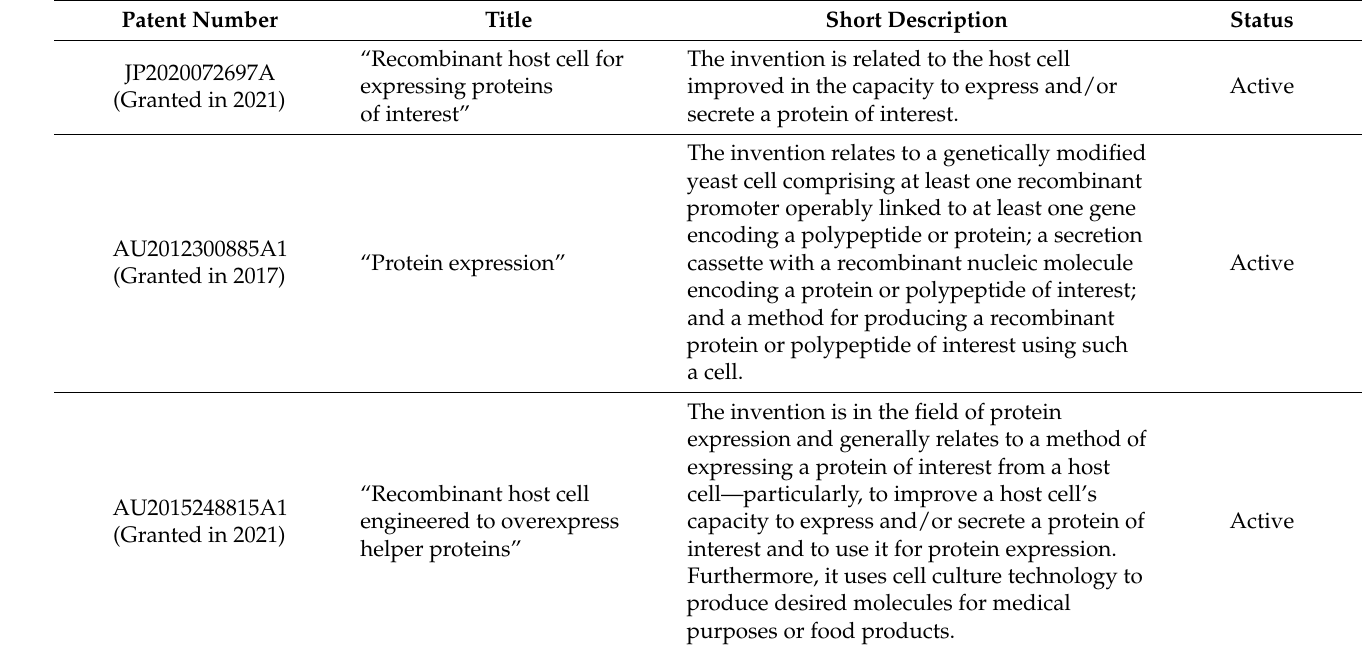
Table 3. Exemplary patents related to the expression and production of heterologous proteins in yeast. Active patents are listed, excluding those pending, expired, or abandoned. Sources: Espacenet [61], and Google Patent